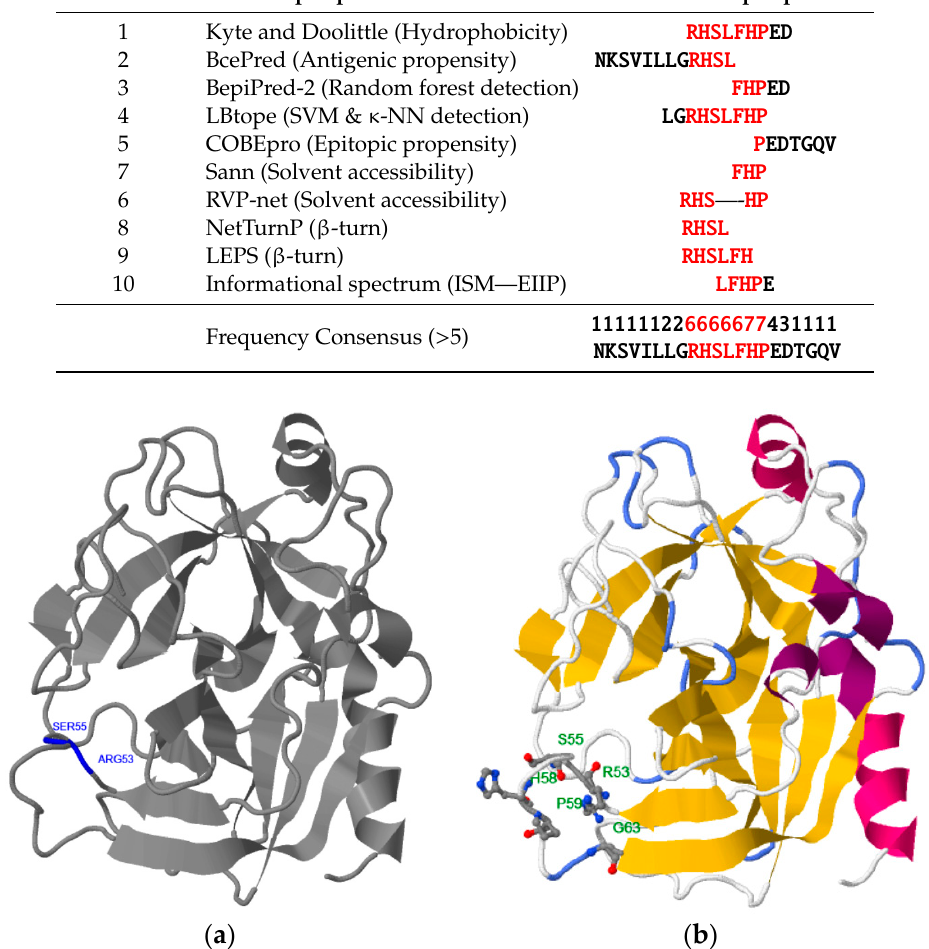
Table 2. Prediction of hPSA epitope RHSLFHP was obtained using 10 epitope prediction methods. Table 1. Targeted epitope sequences of the human prostate specific antigen (hPSA) molecule, verified in previous studies.